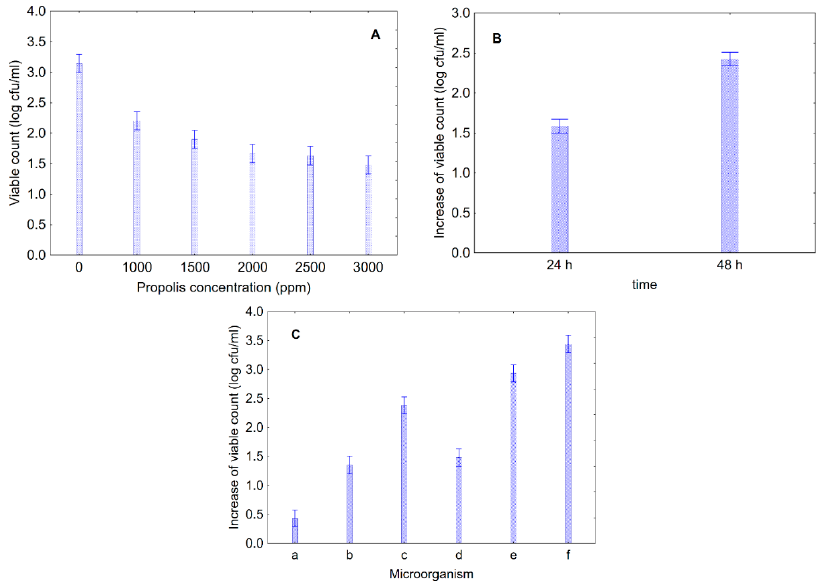
Figure 3. Decomposition of the statistical hypothesis on the increase of viable count of yeast and bacteria. Bars denote 95% confidence intervals. A , effect of propolis concentration; B , effect of time; C , effect of kind of microorganism. a, D. hansenii ; b, S. cerevisiae ; c, H. alvei (col8); d, Enterobacter sp. (col9); e, Ps. fluorescens ; f, Ps. putida .